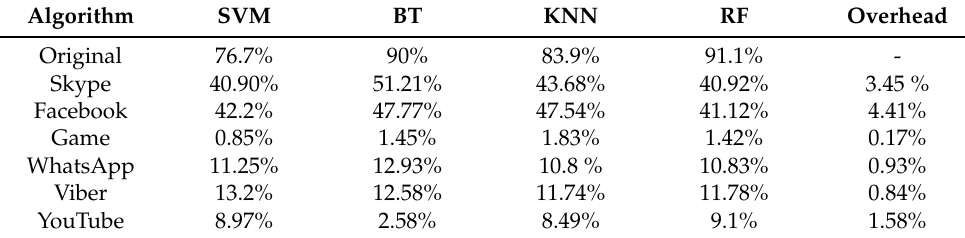
Table 11. Results of apps mutation, using